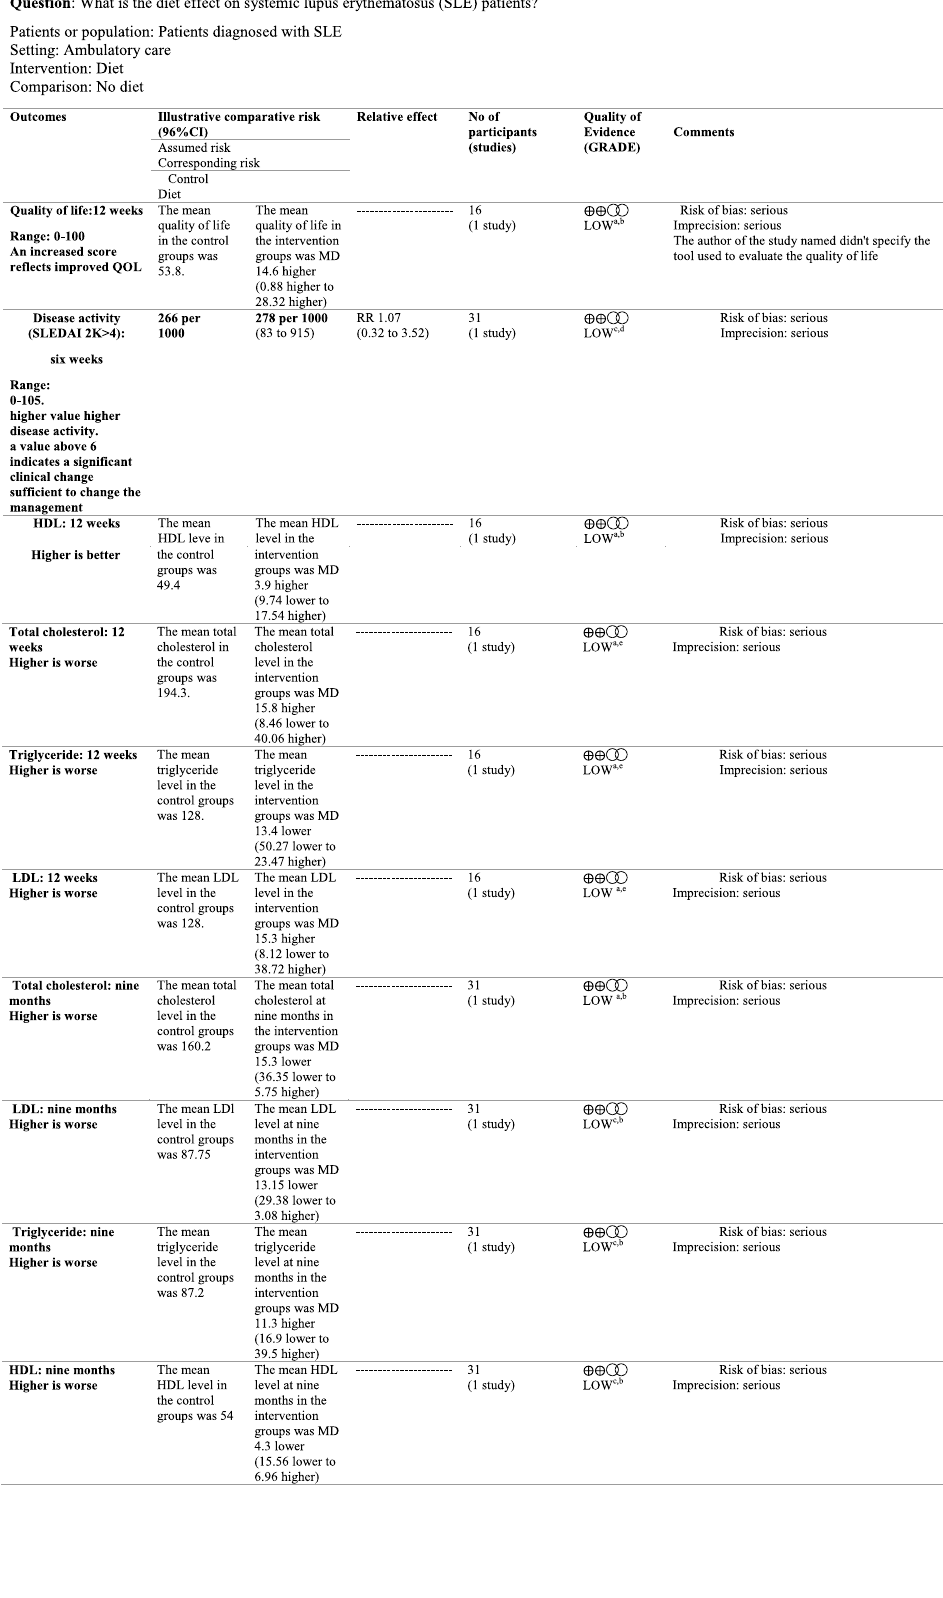
Table 4 Summary of